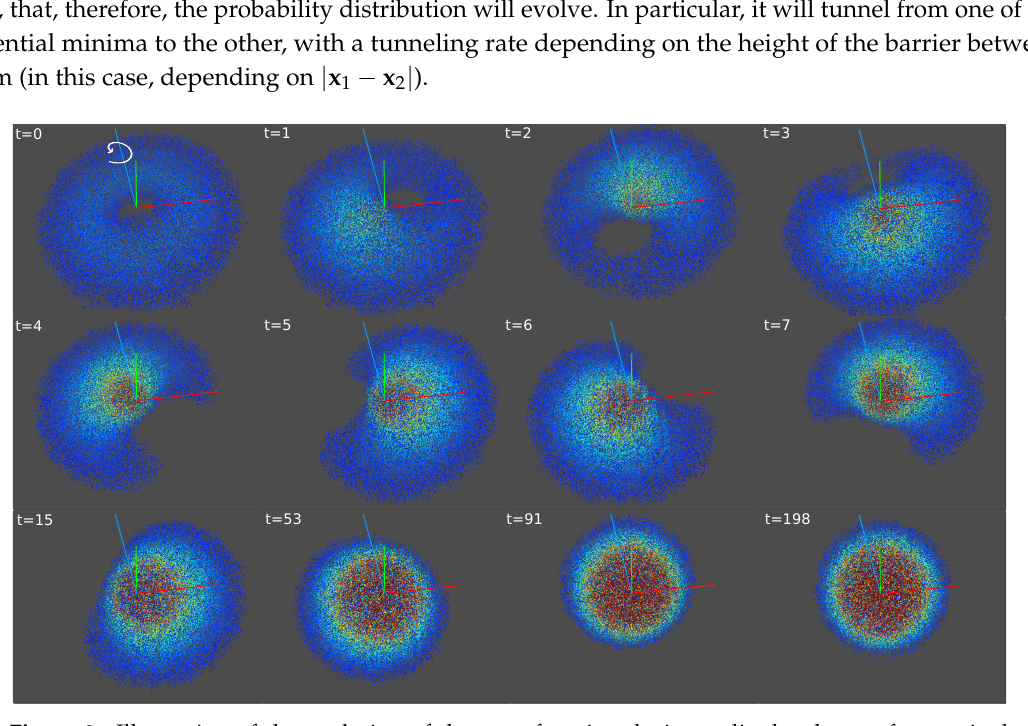
Figure 9. Illustration of the evolution of the wavefunction during a dipolar decay of an excited eigenstate of the hydrogen